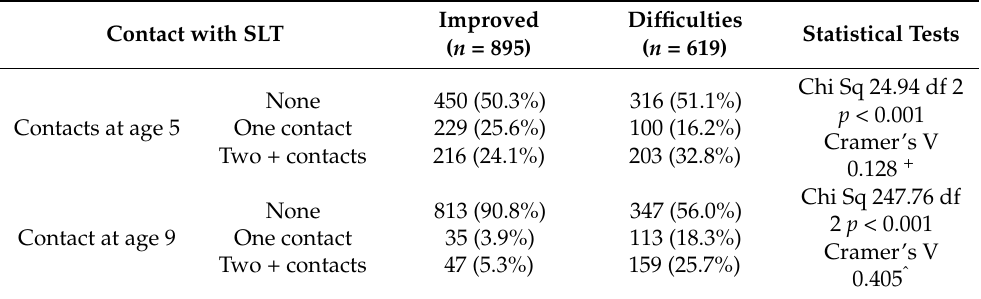
Table 5. The percentage of children who had contact in past 12 months with a speech and language therapist (SLT) at age 5 and age 9 for those who had improved and those experiencing difficulties at age